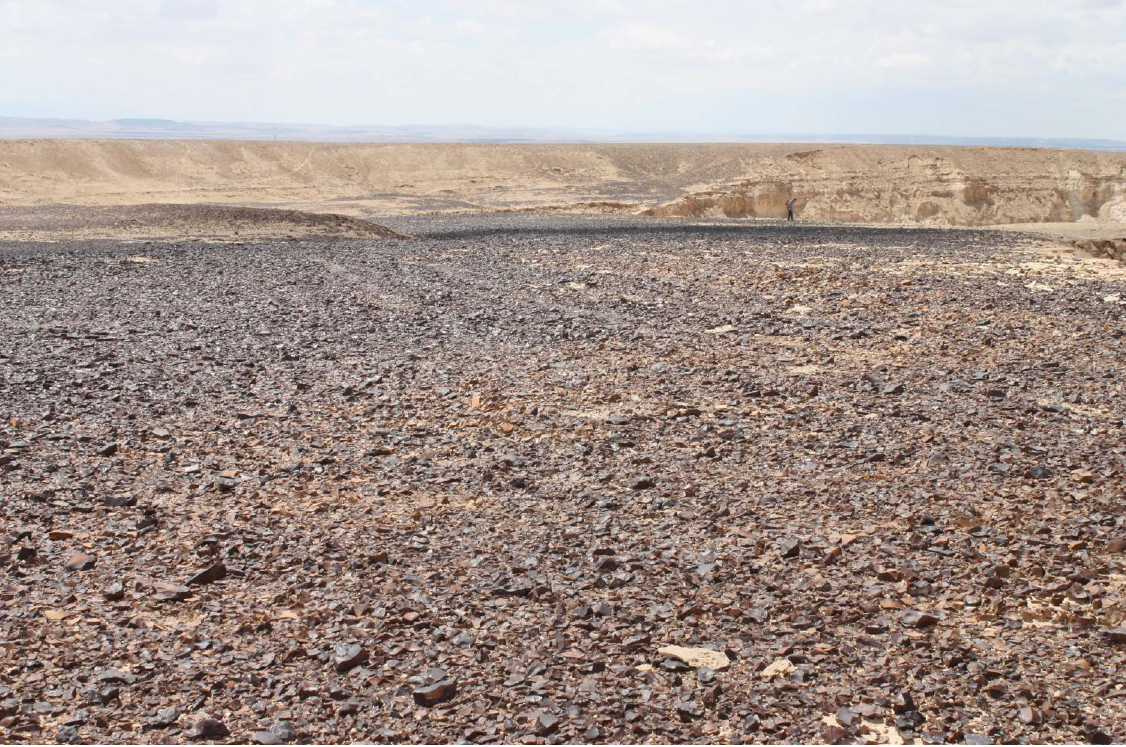
Figure 3. General view of the desert pavements on the top of Zehiha hills. Within the area surveyed numerous concentrations of Middle Paleolithic artifacts were noted. Field observations indicate that all artifacts in these concentrations were produced by Middle Paleolithic technologies. Nubian cores (Figure 4a,b) were found in association with centripetal and bidirectional Levallois cores. Some of the scatters were composed of both cores and debitage, while others were mostly composed of cores. Of special note is the presence of large thin flint slabs that were used as Levallois cores, mostly for centripetal recurrent flaking (Figure 4b and 5). These cores are 30-40 cm in length and only a few cm thick. While no cortex appears on the flaking surface, the preparation face is covered almost entirely by cortex, with only small preparation flakes removed from the circumference of the face. Only a handful of artifacts were collected for scanning (Figure 5) from this site thus the ratio between Nubian core and other Levallois and non Levallois cores at this find spot is not